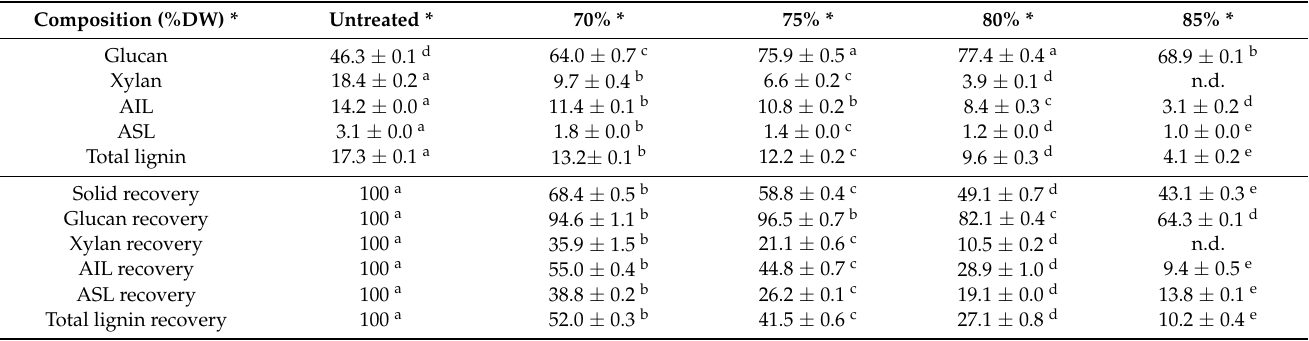
Table 3. Chemical composition of core fiber in kenaf biomass after pretreatment.